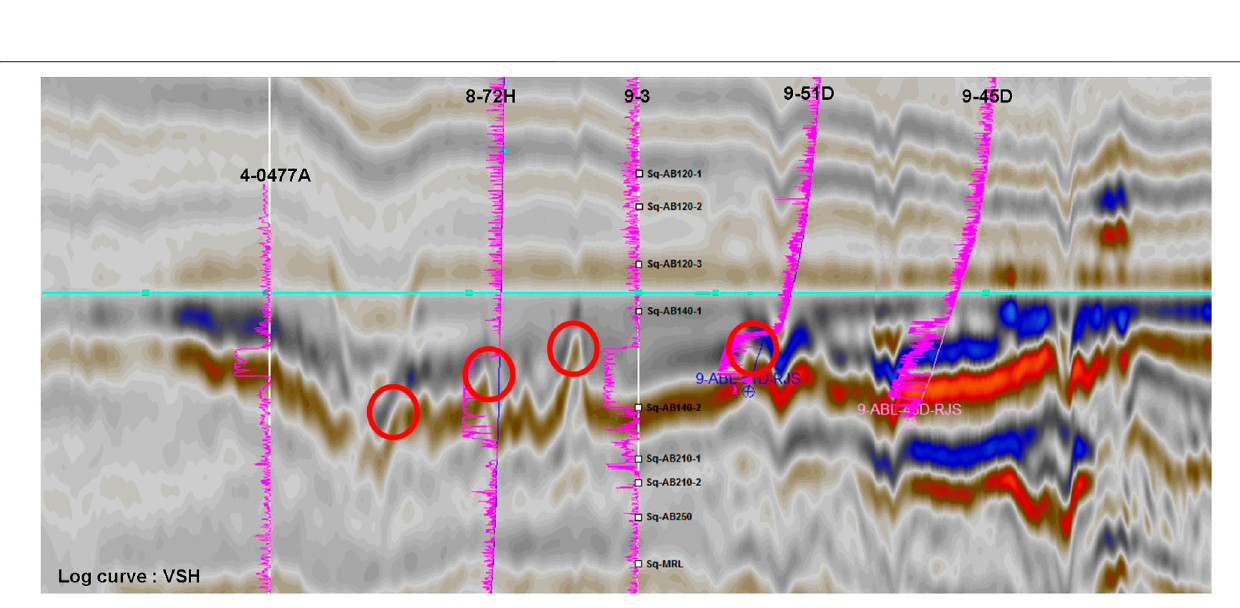
FIGURE 13 | Seismic amplitude change of architecture boundary characteristics for sand body in ABL oil fi eld.